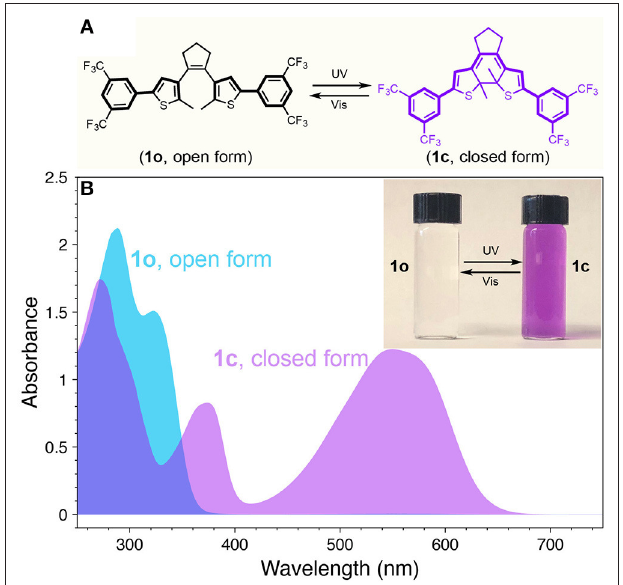
FIGURE 1 | (A) Chemical structures and photoisomerization of diarylethene 1 (Vis = visible). (B) UV-vis absorption spectra of 1 at open ( 1o ) and closed ( 1c ) forms. Inset: photograph for the THF solution of 1o (left) and 1c (right).